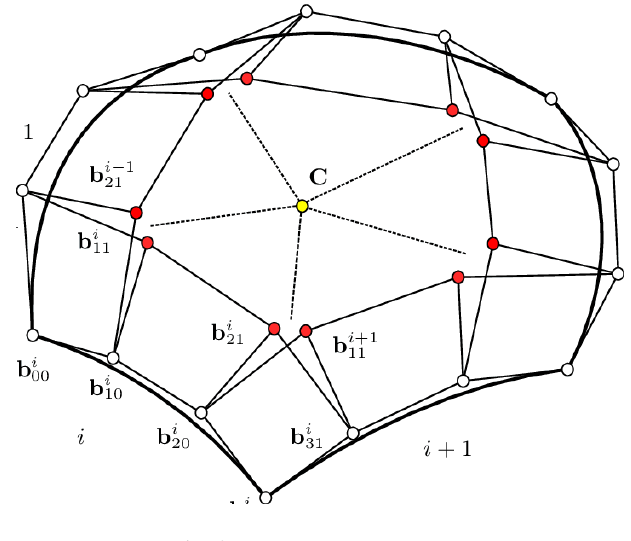
Fig. 3 Gregory patch